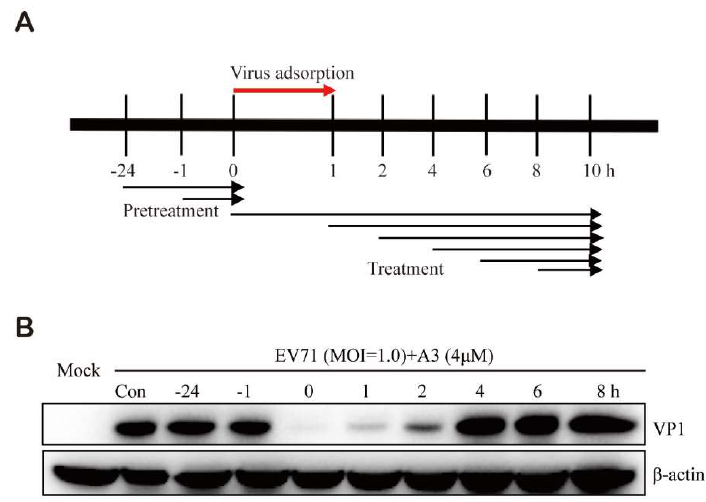
Figure 3. Time-of-addition analysis of Vero cells with compound A3 treatment prior to, during or after EV-A71 infection. ( A ) Schematic illustration of experiment to determine which stage of EV-A71 viral cycle was inhibited by compound A3 in Vero cells. ( B ) EV-A71 VP1 expression in Vero cells was significantly decreased when compound A3 (4 µM) was administered at 0, 1 and 2 h after EV-A71 infection (MOI = 1.0) but not at the other time periods. For all experiments, the collected cells were washed with PBS after 10 h post viral infection, and viral VP1 expression was determined via Western blot assay.